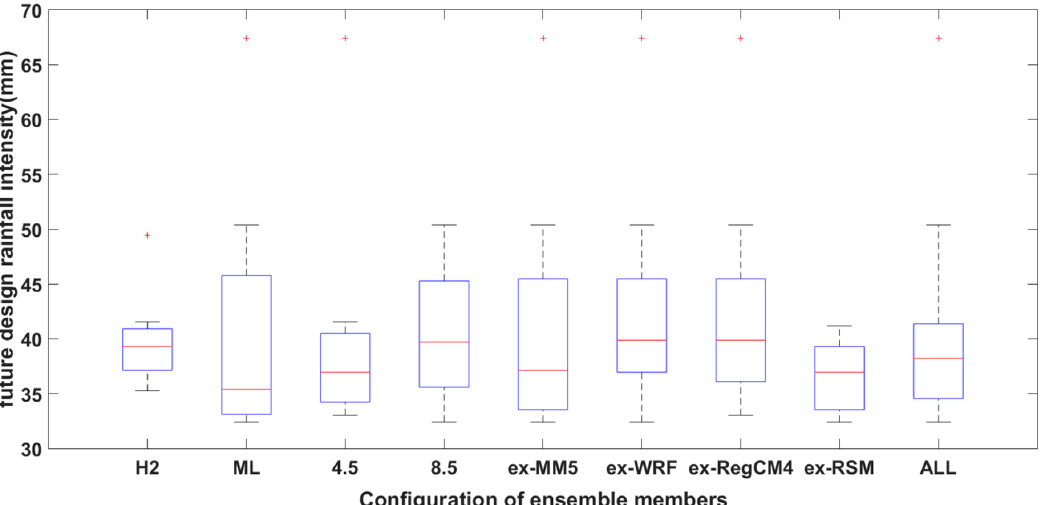
Figure 10. Boxplot of rates of change for ensemble member configurations with return period 30 years and duration 3 h at the Uiseong site. The red dot means the median of the ensembles (i.e., FEA). Boxplots are the results of estimating rate of change and uncertainty using a total of 9 configurations including two GCM-based configurations (H2/ML), two RCP-based configurations (4.5/8.5), four configurations except specific RCM (ex-MM5/ex-WRF/ex-RegCM4/ex-RSM), and the configuration with all 16 GCM/RCM/RCP combination ensembles (ALL).